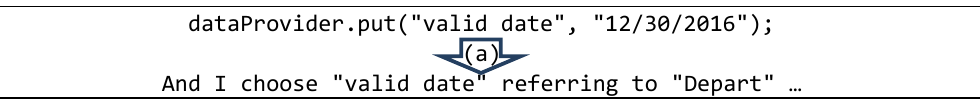
Figure 29. Data in Data Provider: (a) data being associated to a variable to be used in the